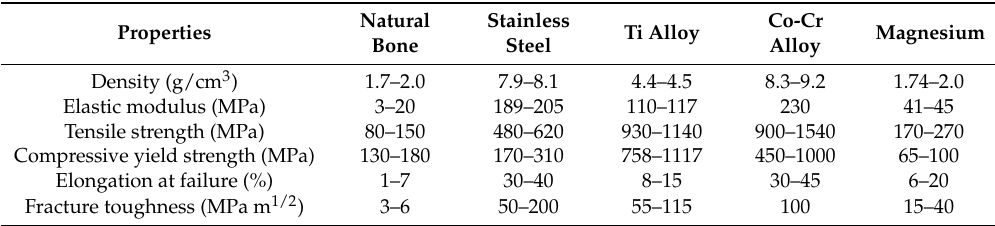
Comparison of the mechanical properties of natural bone with various implant materials [11,15,19,43–46].